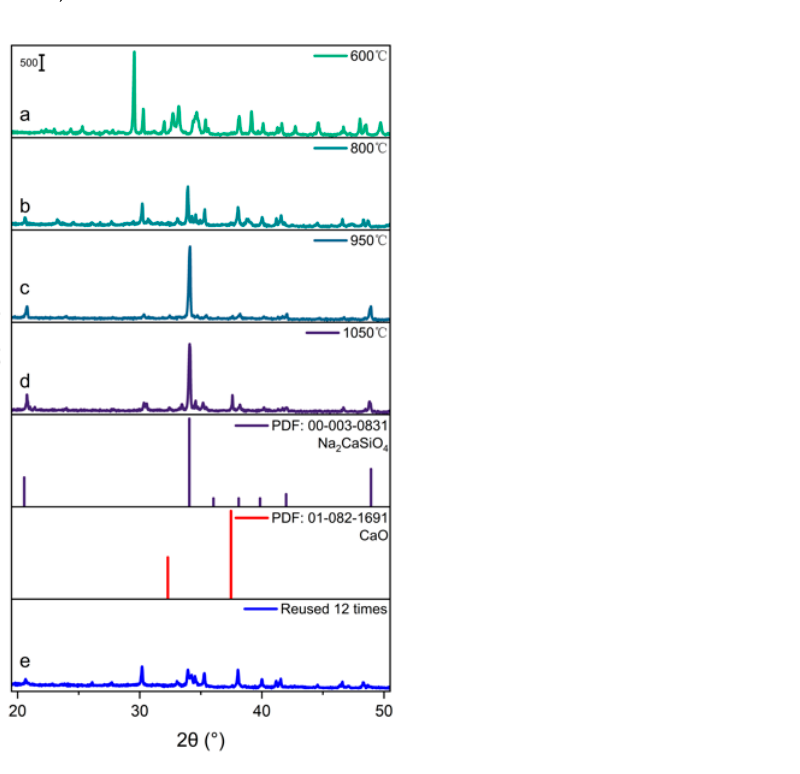
Figure 2. SEM images of the NCSO calcinated at different temperatures: ( a ) 600 °C; ( b ) 800 °C; ( c , d ) 950 °C; ( e , f ) 1050 °C; ( g , h ) NCSO reused for 12 cycles.